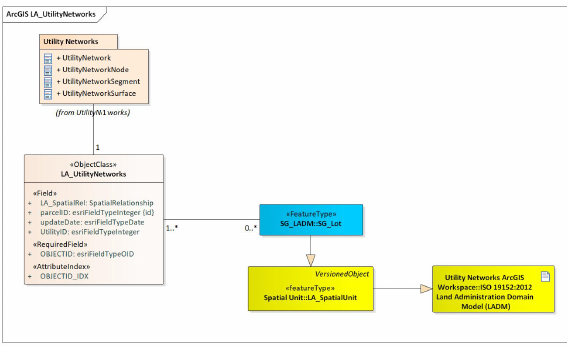
Figure 7. The connection of utility networks and land administration.